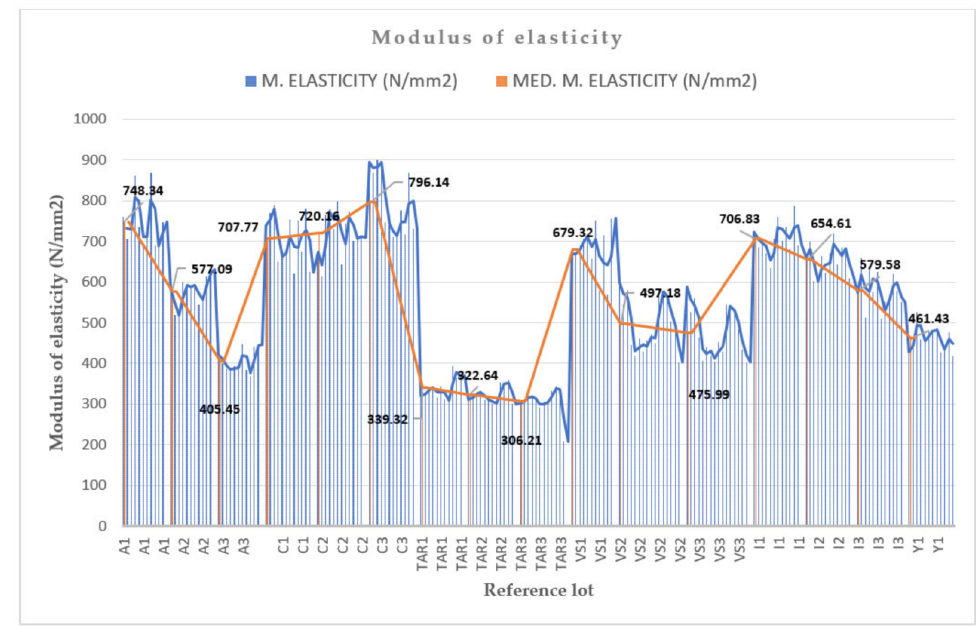
Scheme 5. Modulus of elasticity values for the different tests and additives.